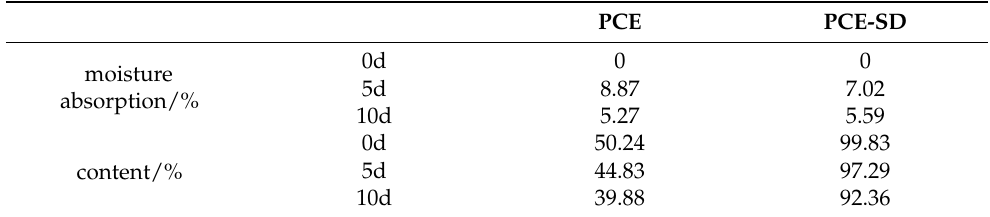
Table 4. The content and moisture absorption under high humidity (saturated KNO3 solution, RH 90% ± 5%).